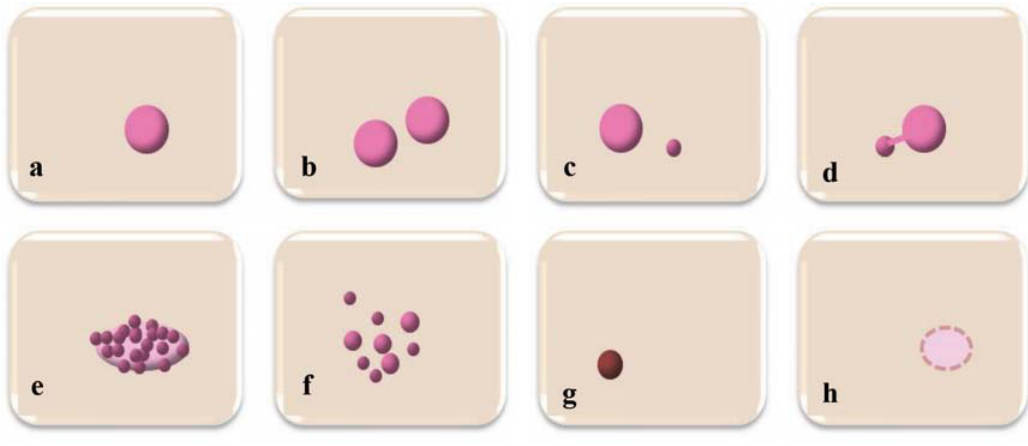
FIGURE 1. Schematic diagram of different types of buccal cells and the possible mechanisms for their origin; (a) normal differ- entiated cell (normal genome); (b) binucleated cell (cytokinesis defect); (c); micronucleated cell (chromosome breakage or loss); (d) nuclear bud (gene ampli fi cation); (e) condensed chromatin (apoptotic cell death); (f) karyorrhexis (apoptotic cell death); (g) pyknosis (apoptotic cell death); (h) karyolysis (necrotic cell